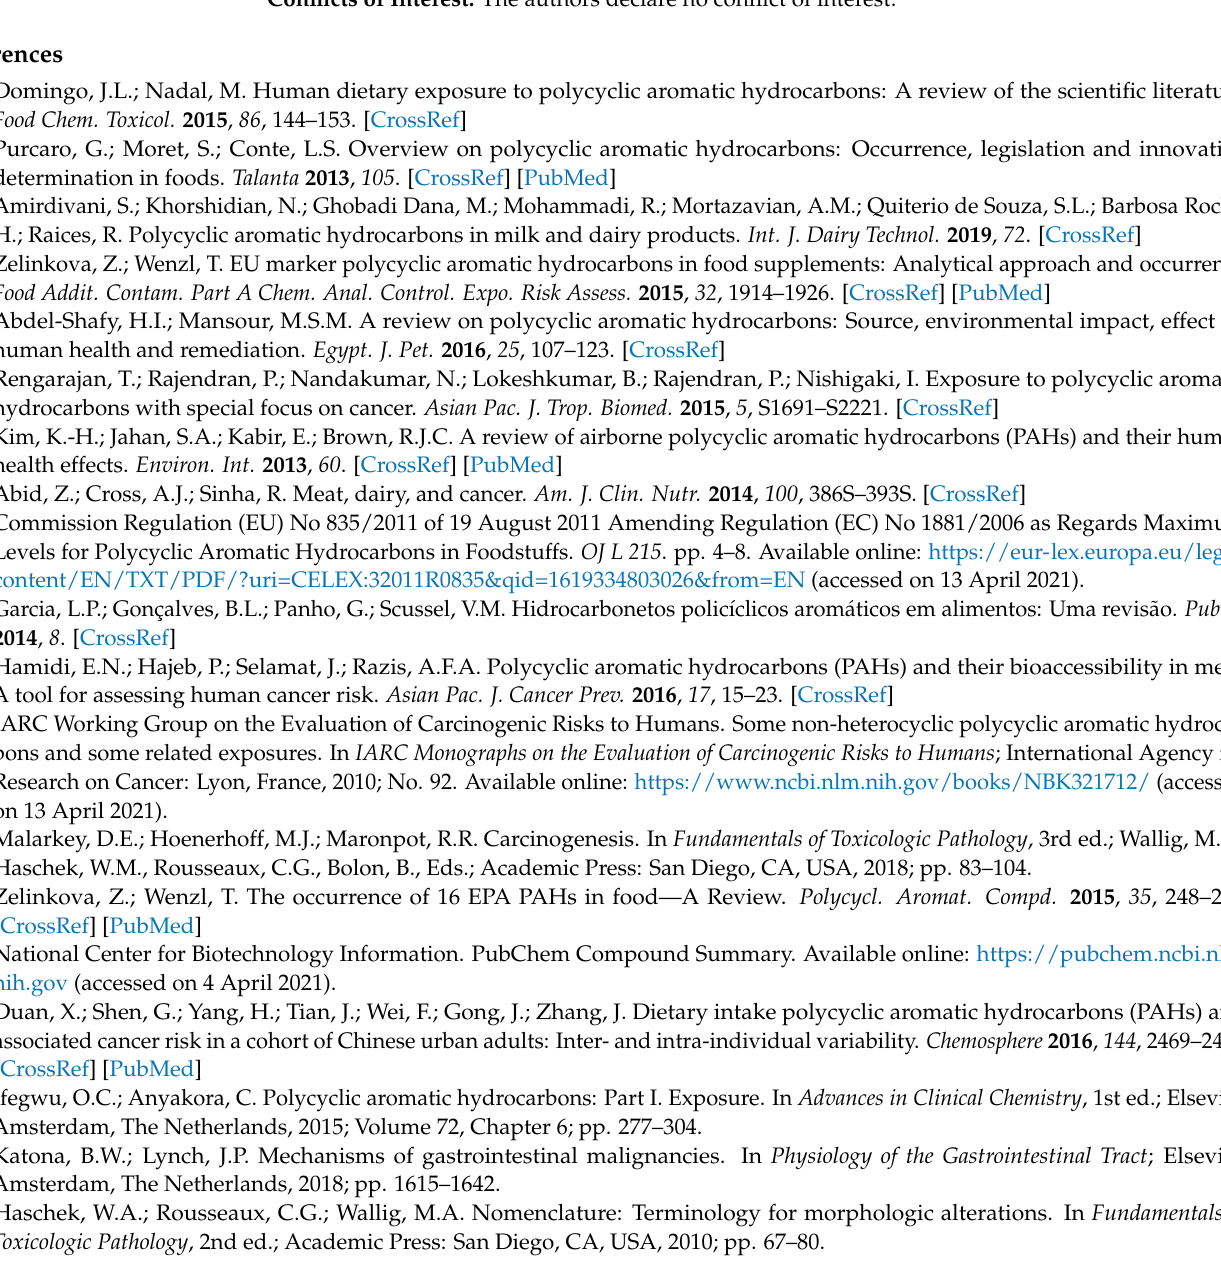
figure. M.M.R. revised the manuscript, tables, and figure. A.C.C.P.-L. revised the manuscript, tables, and figure. E.A.F.S.T. supervised the manuscript finalization. All authors have read and agreed to the published version of the